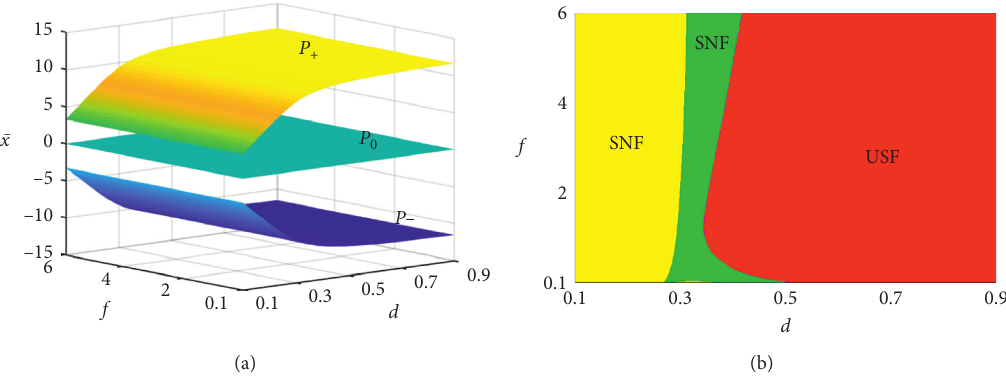
Figure 2: The values of x and the stability distributions of the nonzero equilibrium points. (a) The solutions of x . (b) The stability distributions of P ± in the d–f parameter